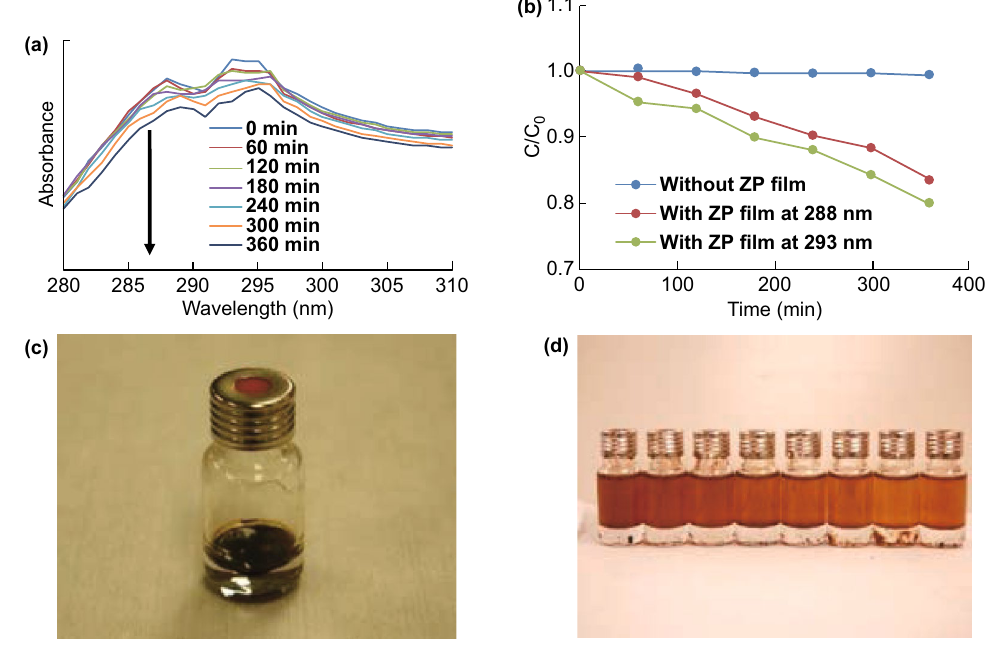
Fig. 10 a UV–Vis spectrum of the crude oil. b Degradation profiles of the crude oil (at 288 and 293 nm). Photographs of the crude oil c before photodegradation and d after